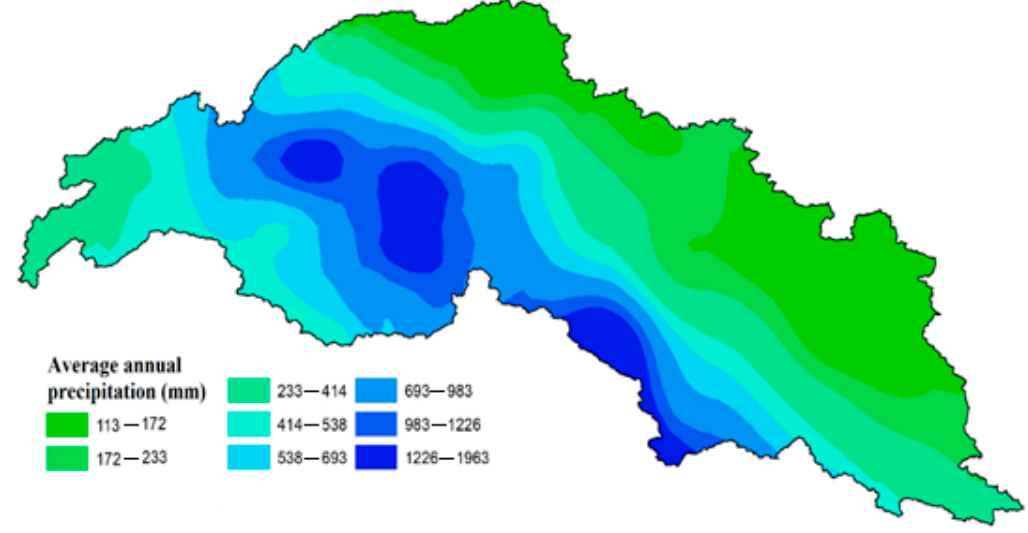
Figure 5. Spatial distribution of the average annual precipitation in the study area.